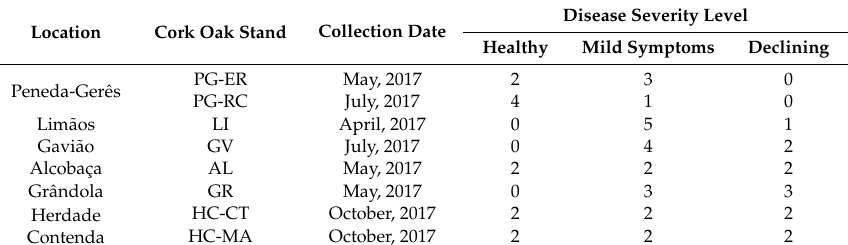
Table 1. Collection of cork oak branches in sampled forests. The number of trees sampled from each disease severity level is presented. For more details of sampled forests, see Table S1.